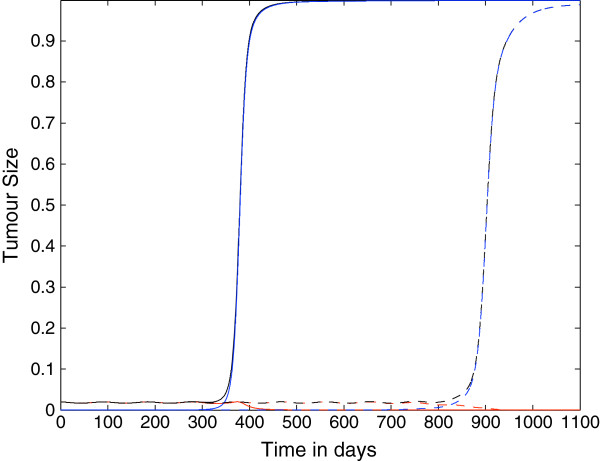
Growth of the tumour cell population: nonspatial case 5. Plots showing the growth of the tumour cell population over time in the case where the spatial components of the model (i.e. all diffusion, taxis terms) have been set to zero. The plots show that the tumour can evade the immune system for either approximately 350 days or approximately 850 days depending on the parameter N. In this case however, the initial population T0is eradicated. Parameter values: pi=constant=0.9997 and ki+ are linearly decreasing functions and: N=4 (solid line) and N=10 (dashed lines). The red lines represent the population T0, the blue lines represent the summed populations T1 + … + TN, and the black lines represent the summed populations T0 + … + TN. Time t is in days.